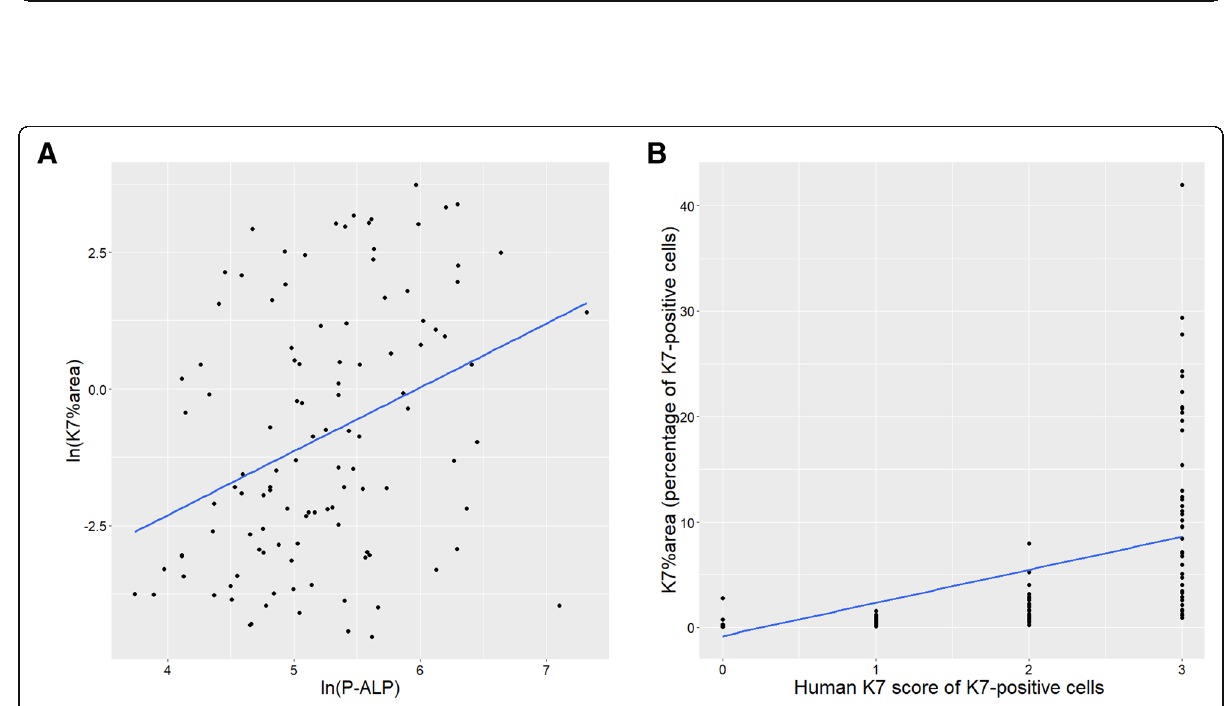
Fig. 6 The K7-AI model ’ s results (K7%area) vs the human estimate of K7-positive hepatocytes (human K7 score), and the logarithm of the K7-AI model ’ s results versus serum ln (ALP)